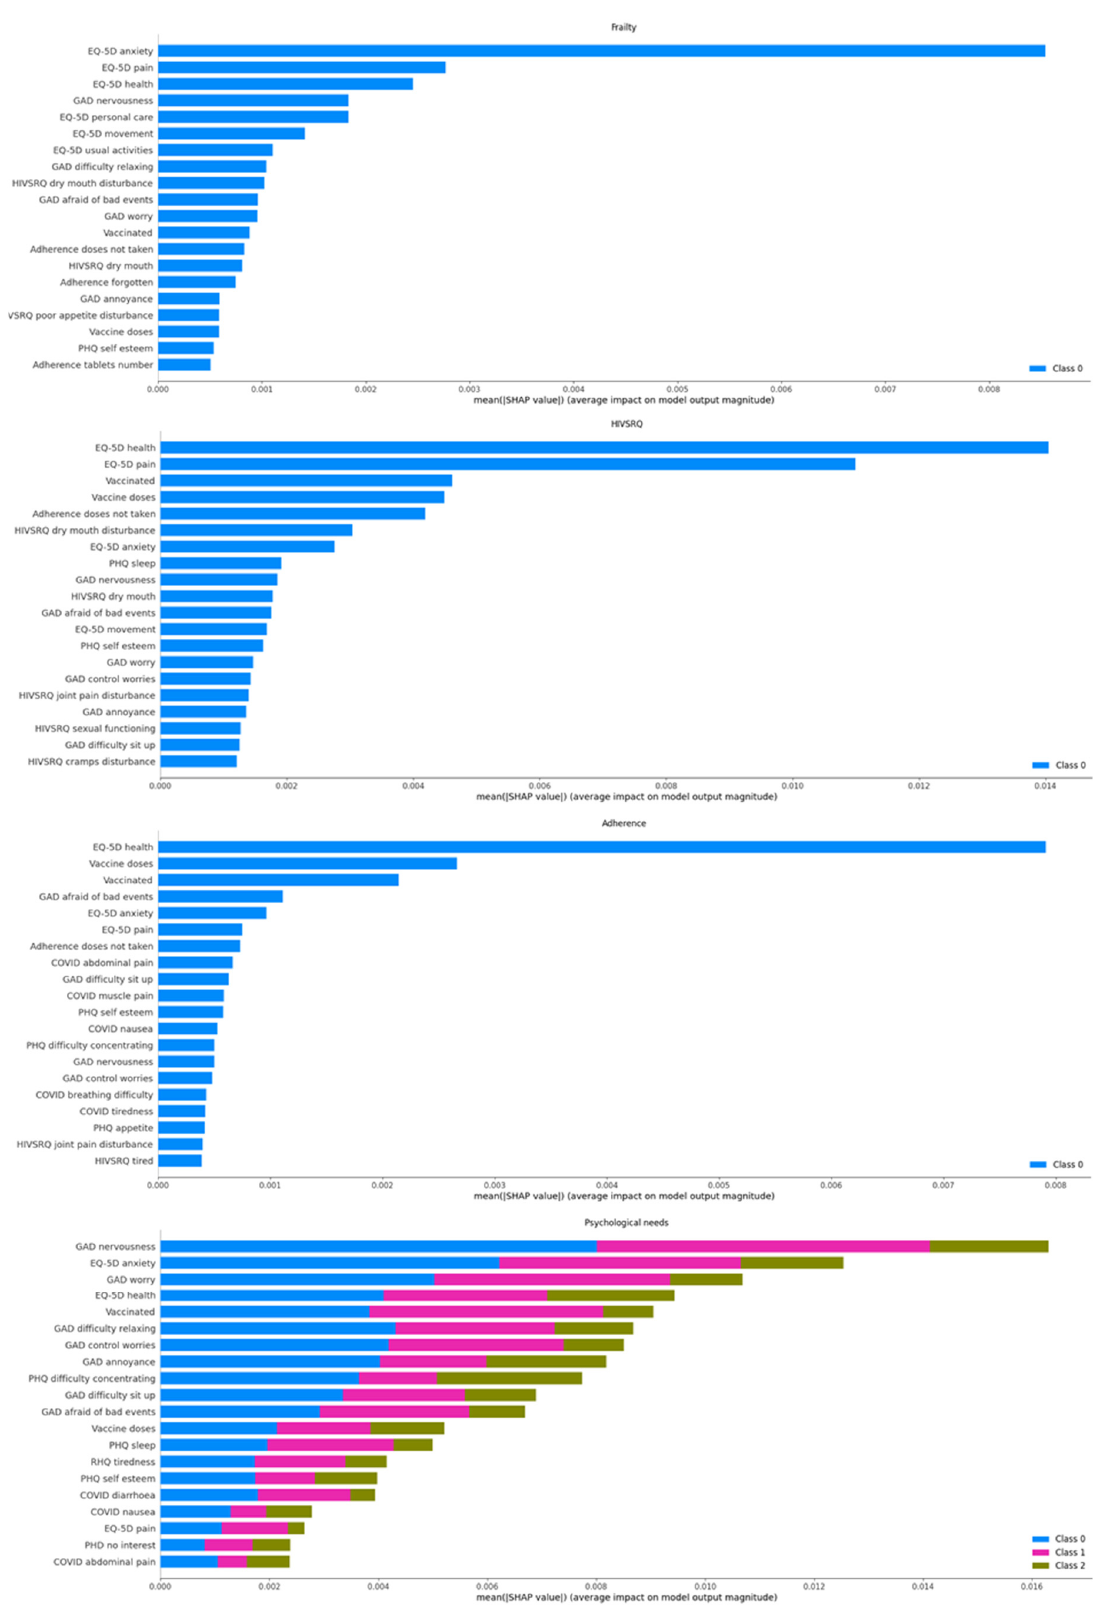
Figure 5. SHAP analysis of the classifier decisions to obtain the most important attributes affecting the decisions of either positive or negative outcomes.